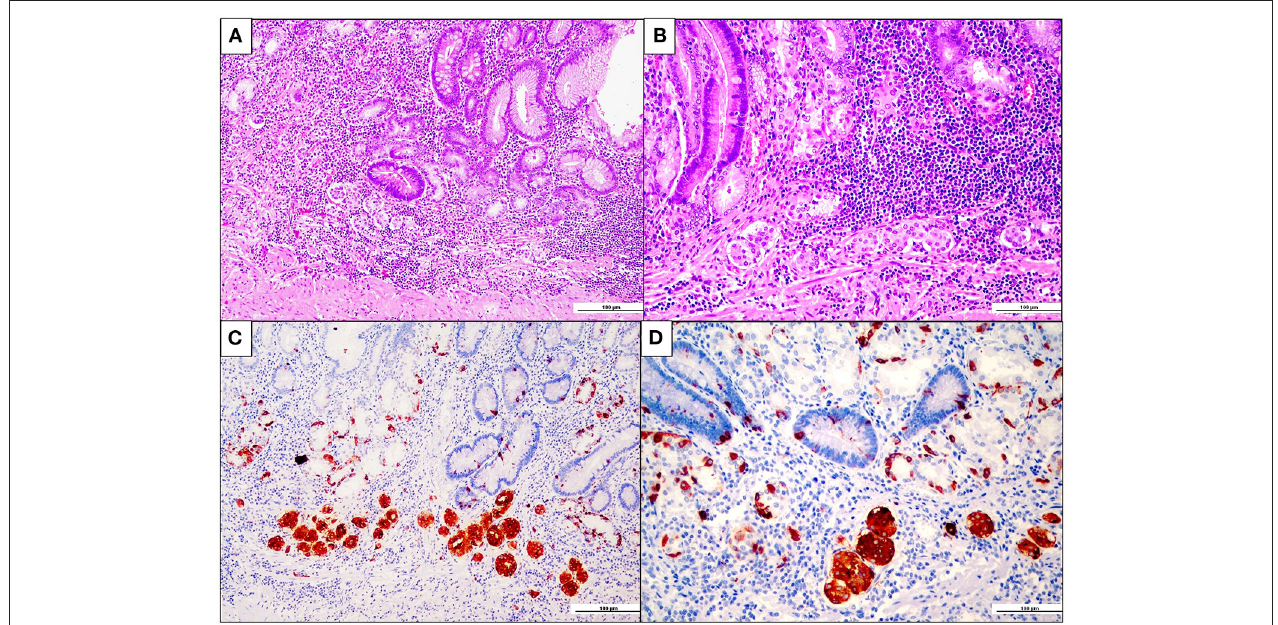
FIGURE 3 | Fundus enterochromaffin-like (ECL) cell hyperplasia and dysplasia. (A,B) Oxyntic mucosa showing severe atrophy with extensive pseudopyloric and intestinal metaplasia. Note the presence of aggregates of closely packed micronodules in the deep lamina propria, at higher magnification in B (hematoxylin and eosin). (C) Chromogranin-A-positive ECL cell adenomatoid hyperplasia, consisting of aggregates of more than four neuroendocrine cell micronodules in the lamina propria (chromogranin-A immunohistochemistry). (D) ECL cell fused micronodules (with no intervening basal membrane), consistent with neuroendocrine cell